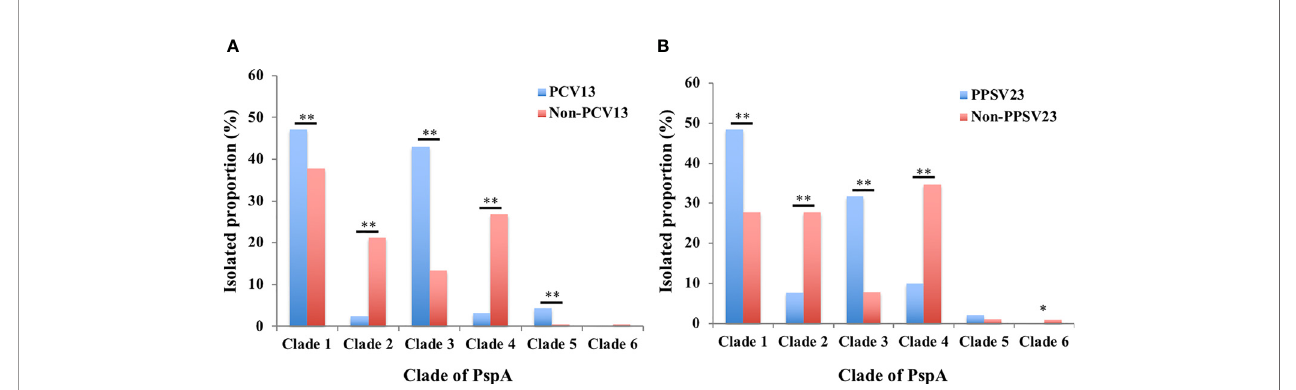
FIGURE 2 | Isolation proportions of PspA clades 1 – 6 among the S. pneumoniae strains of vaccine and non-vaccine serotypes. (A) PCV13 and non-PCV13 serotypes, (B) PPSV23 and non-PPSV23 serotypes. The proportions of vaccine and non-vaccine serotypes were compared using c 2 -test (clades 1 – 5) or Fisher ’ s exact test (clade 6) corrected using Bonferroni ’ s method. * p < 0.05, ** p < 0.01. PCV13: 13-valent pneumococcal conjugate vaccine; PPSV23: 23-valent pneumococcal polysaccharide